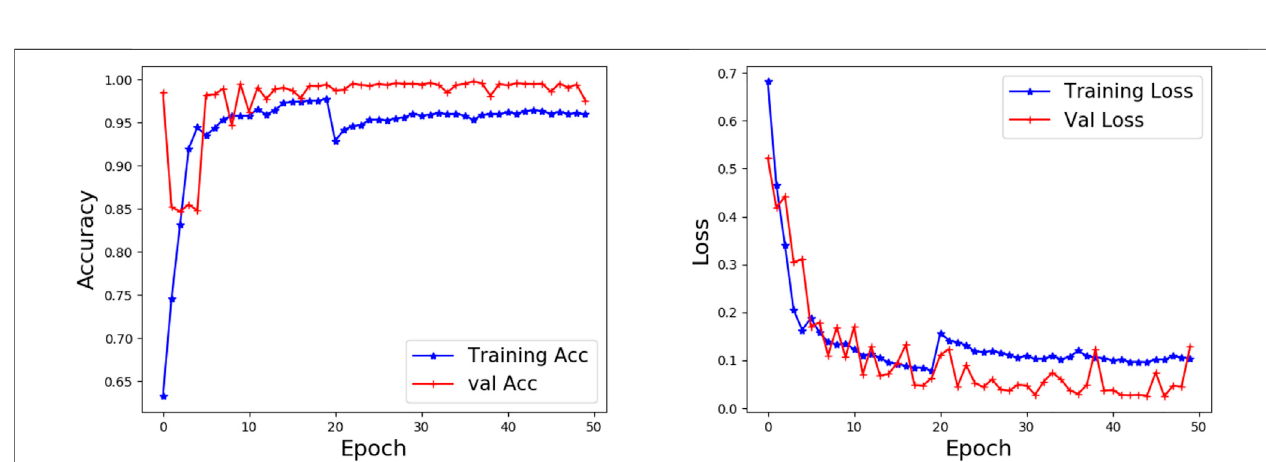
FIGURE 9 | Loss and accuracy performance of the initial model on CICIDS 2017 datasets.